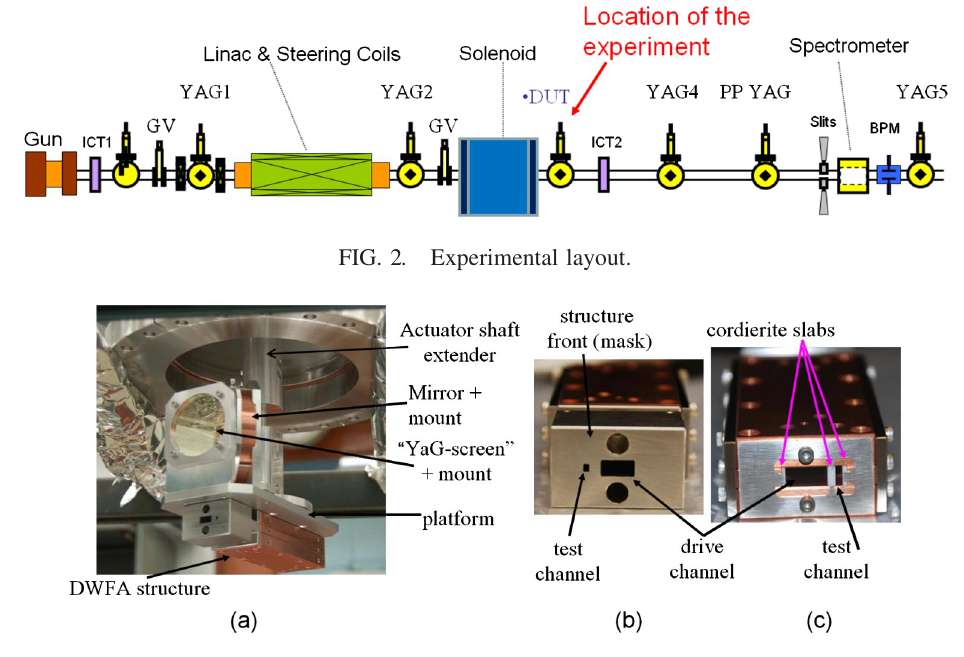
FIG. 3. (a) DWFA apparatus attached to an actuator before it is placed in the vacuum chamber; (b) front view (the apparatus is preceded by a mask to protect the dielectric slabs from the beam halo); and (c) back view of the accelerator